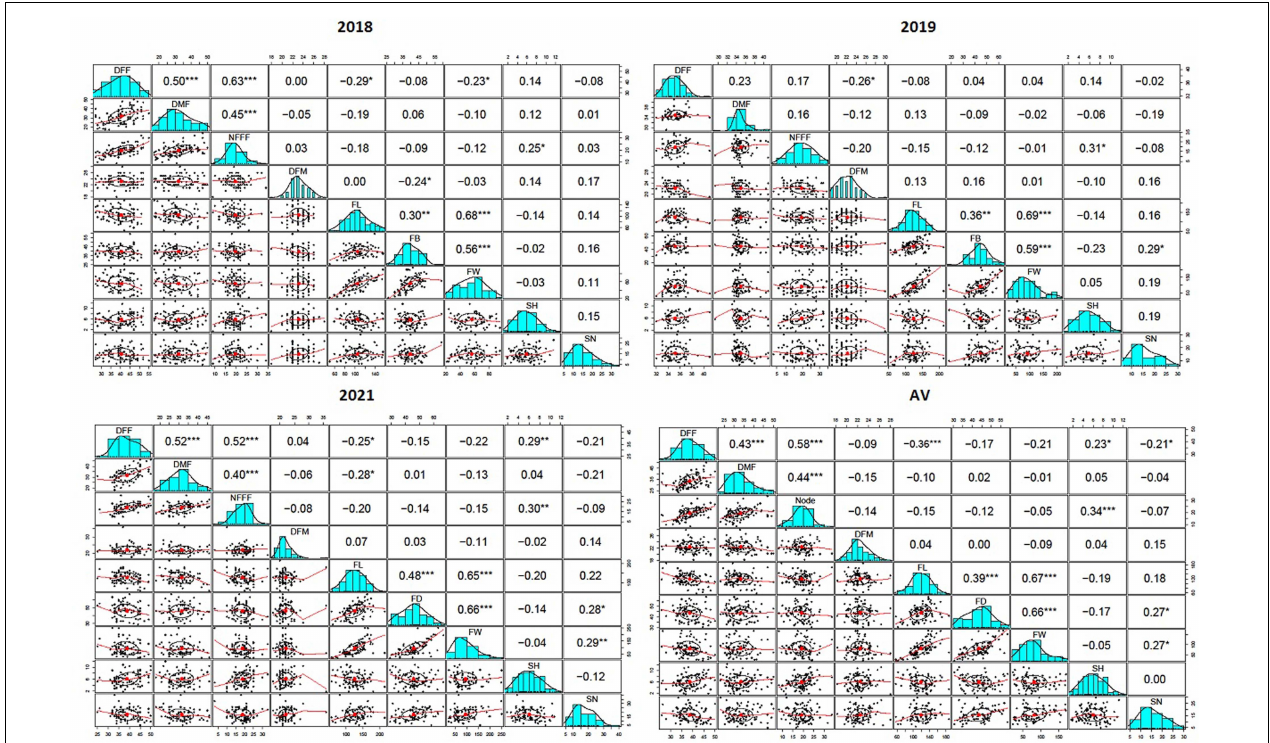
FIGURE 1 | The Pearson’s correlation coefficients ( r ) between nine horticultural traits DFF- days to appearance of first female flower, DMF- days to appearance of first male flower, NFFF- node to appearance of first female flower, DFM- days to fruit maturity, FL- fruit length, FD- fruit diameter and FW- fruit weight, SH- seed hardness and SN- seed number detected in 2018, 2019, and 2021, and average value (AV) environments, *, **, *** indicates level of significance at P ≤ 0.05, 0.01, 0.001